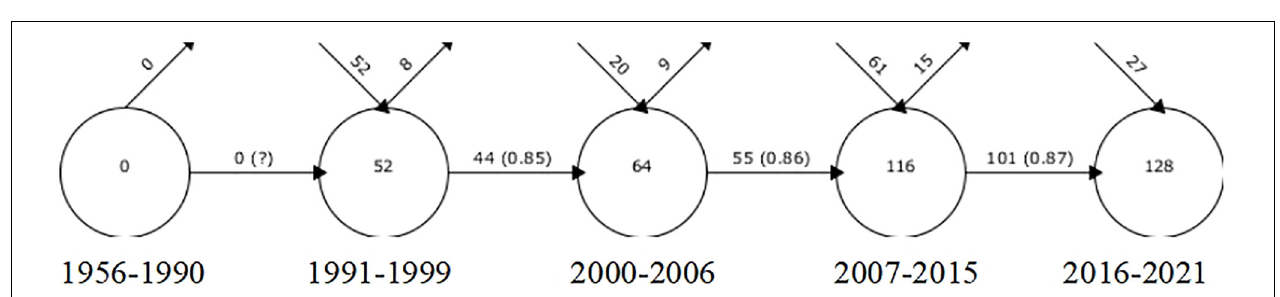
FIGURE 1 | Development of the number of articles over the years.